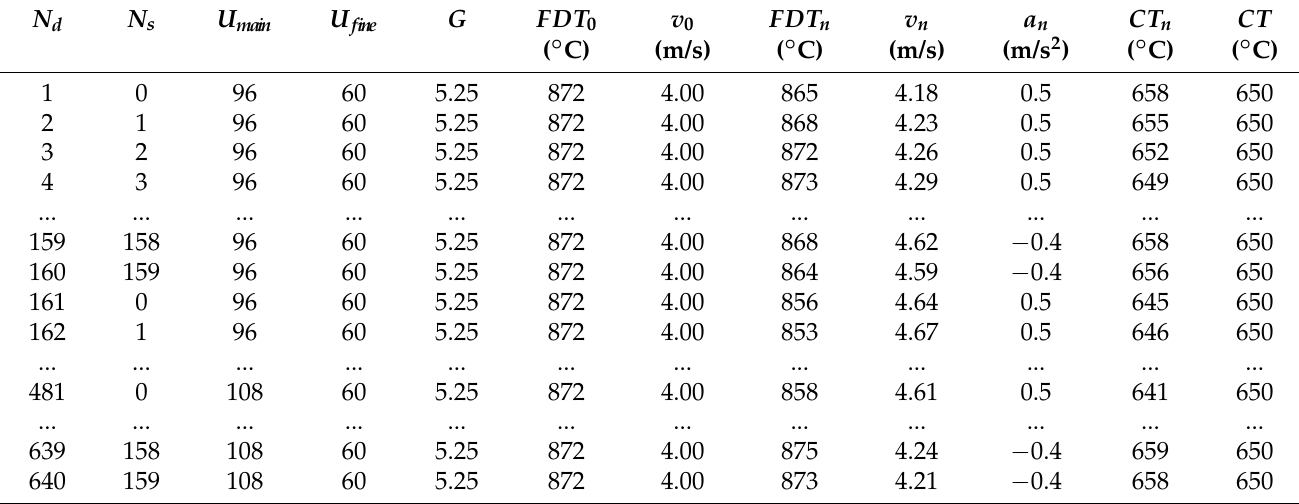
Table 3. Input and output data of modeling with different specifications for